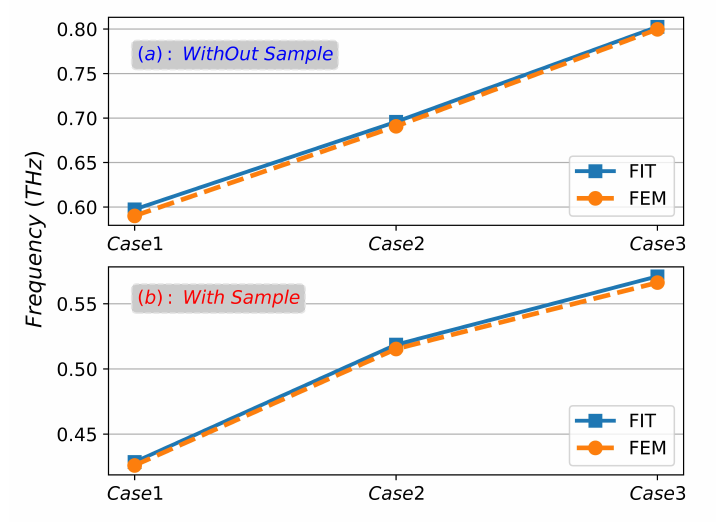
Figure 15. The SPR frequency of SSPPs on CPGS with di ff erent f SSPPs